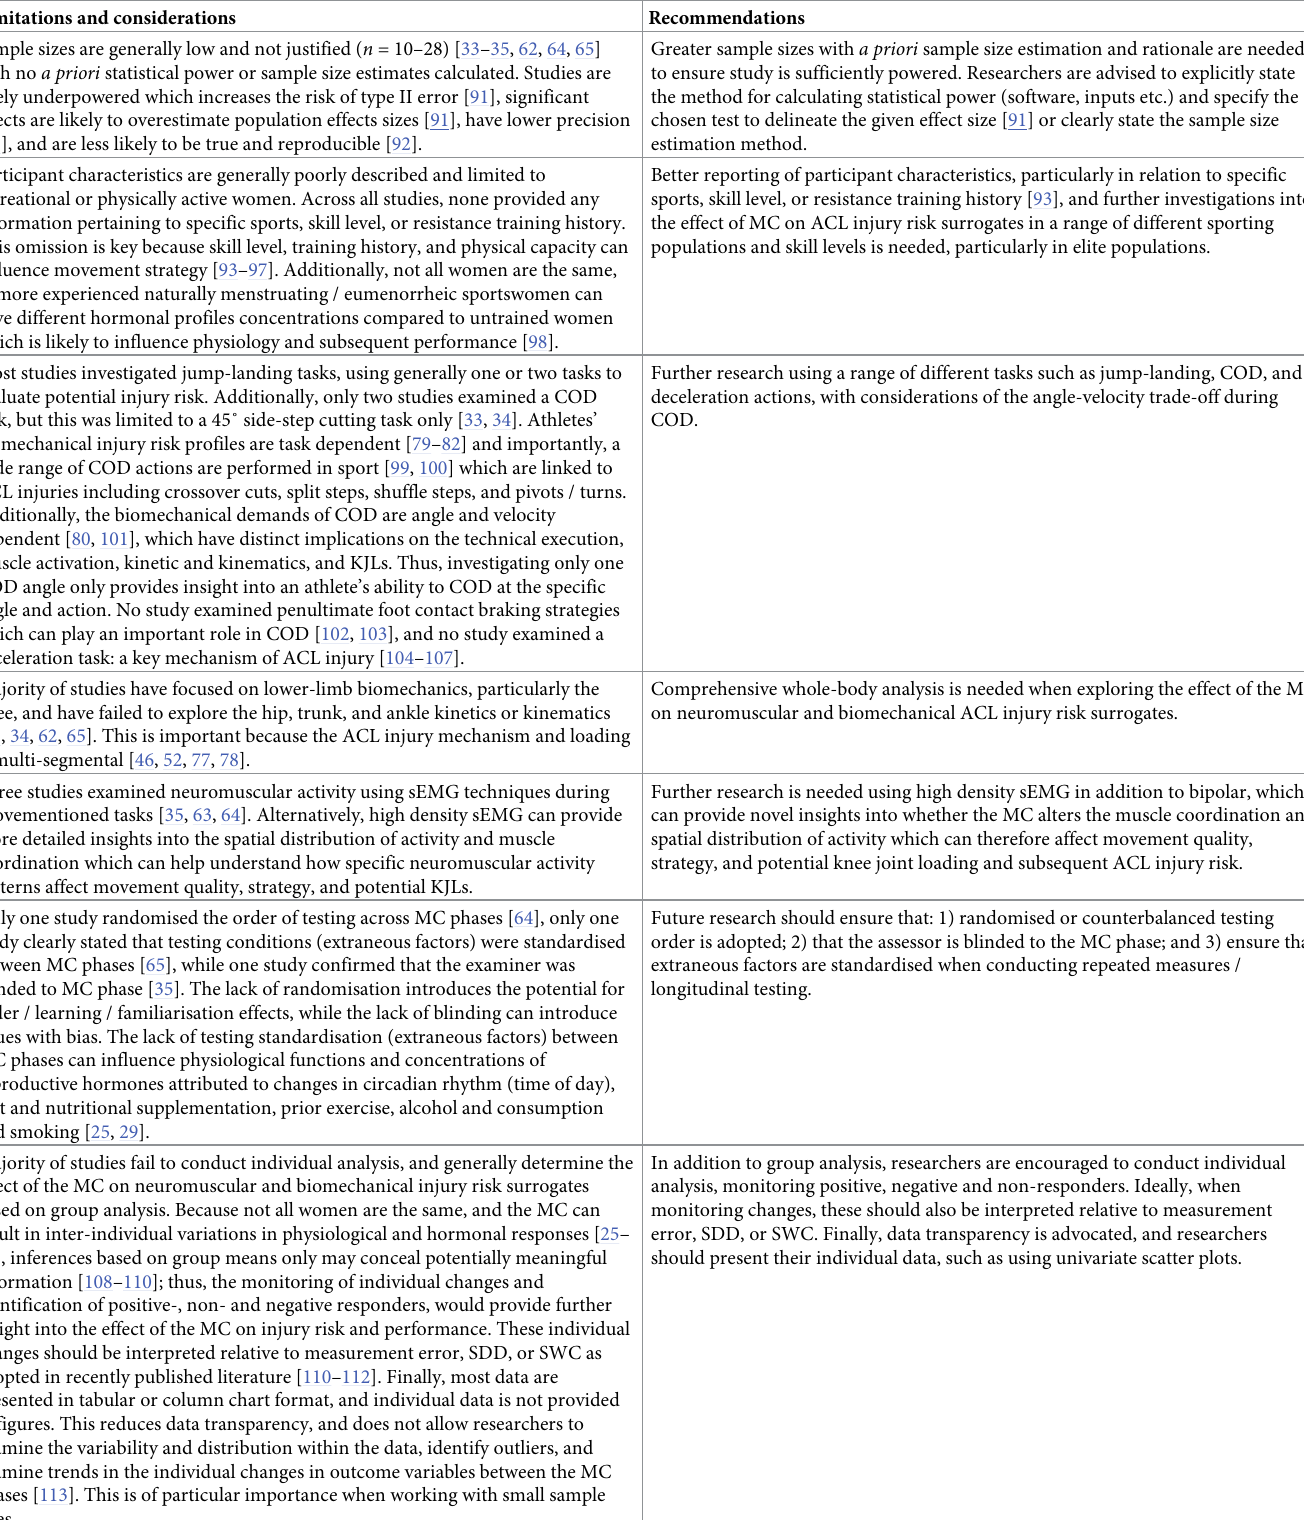
Table 5. Limitations and considerations of the synthesised research pertaining to the effect of the MC on ACL neuromuscular and biomechanical injury risk